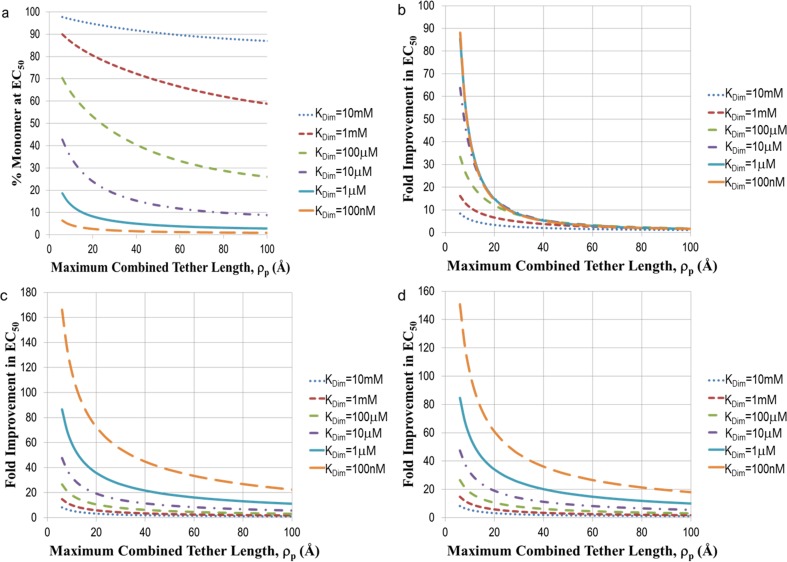
Significant increases in potency are possible for reversibly connected monomers over a wide range of tether lengths and monomer affinities.A) Fraction of monomer in solution at a starting concentration equal to the EC50, as a function of dimerization constant KDim and tether length ρp, when the KD of the monomer is 1 mM. In the remaining insets, fold improvement in the EC50 relative to that for a single site target, single ligand system is plotted as a function of the dimerization constant and tether length with KD = 1 mM B), KD = 1 μM C), or KD = 1 nM D).